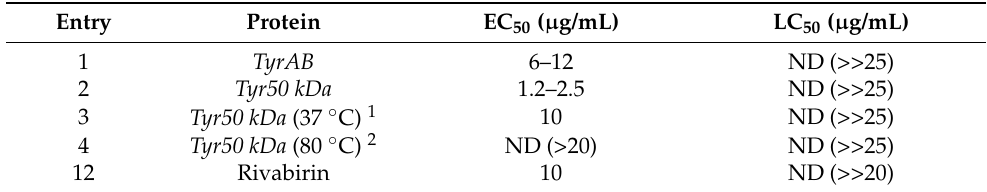
Table 1. EC 50 and LC 50 of the different isoforms of tyrosinase purified from the commercial extract of A. bisporus.